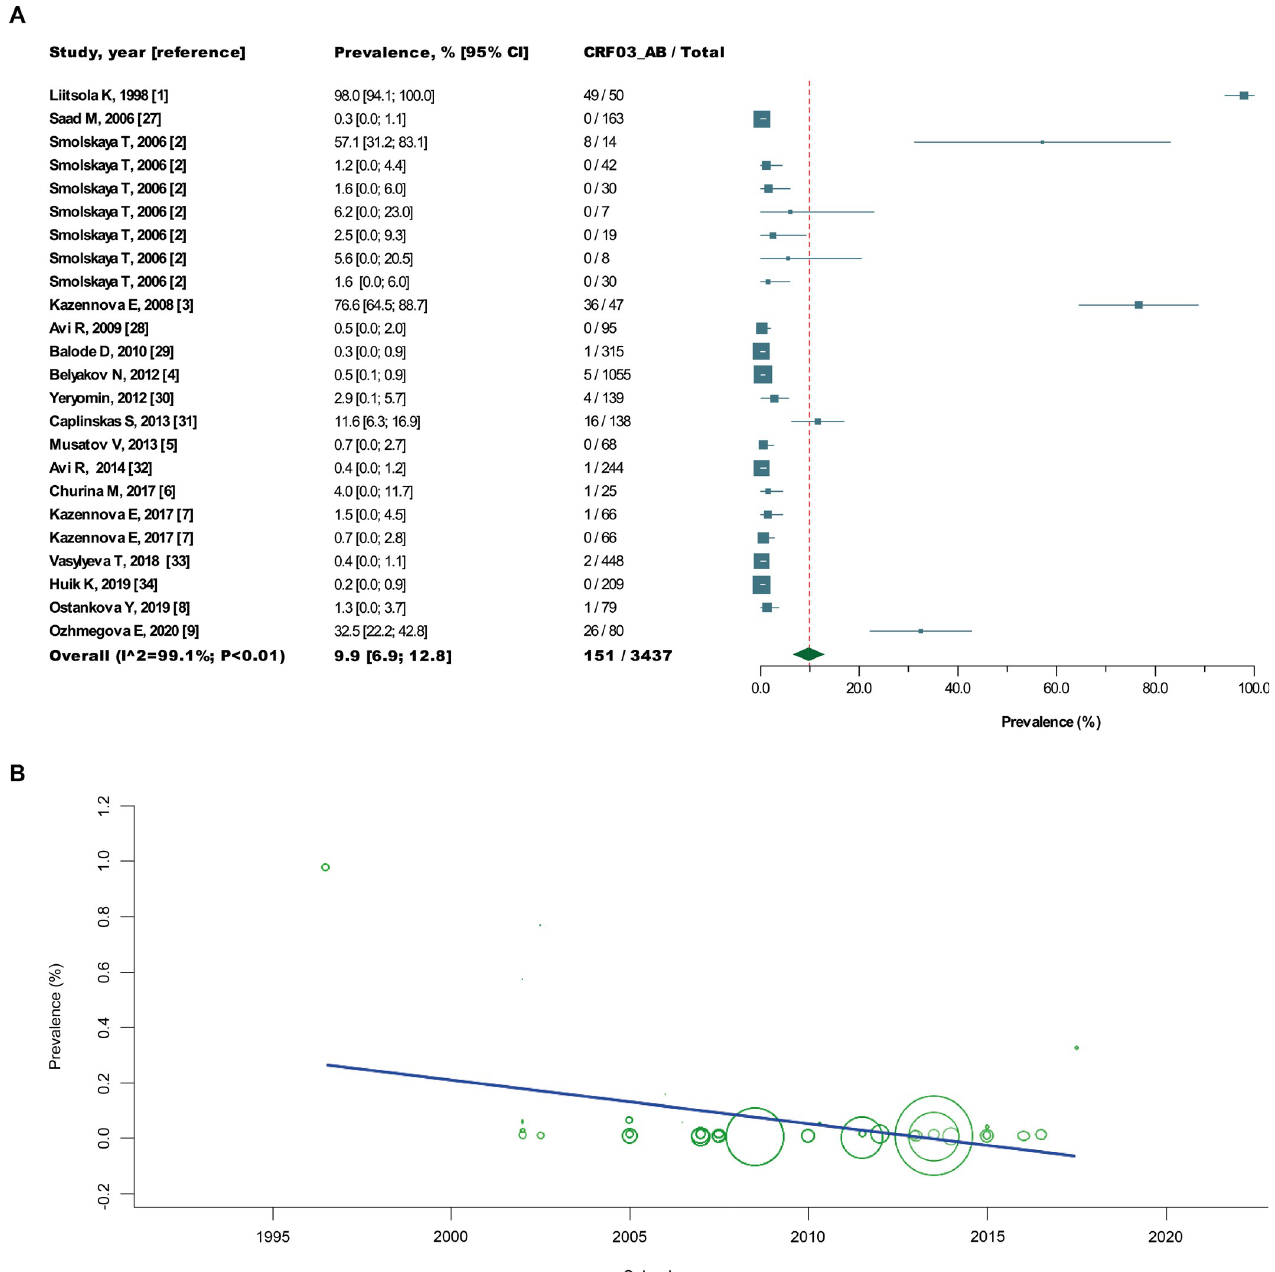
Fig 1. The prevalence of HIV-1 CRF03_AB recombinant in the northwestern FSU countries, including the Northwestern Federal District of Russia. The source links for forest plot (A) numbered according to the list in S1 Table. The x-axis of a meta-regression plot (B) represents year of the samples collection. The diameter of each bubble is proportional to the sample size of each